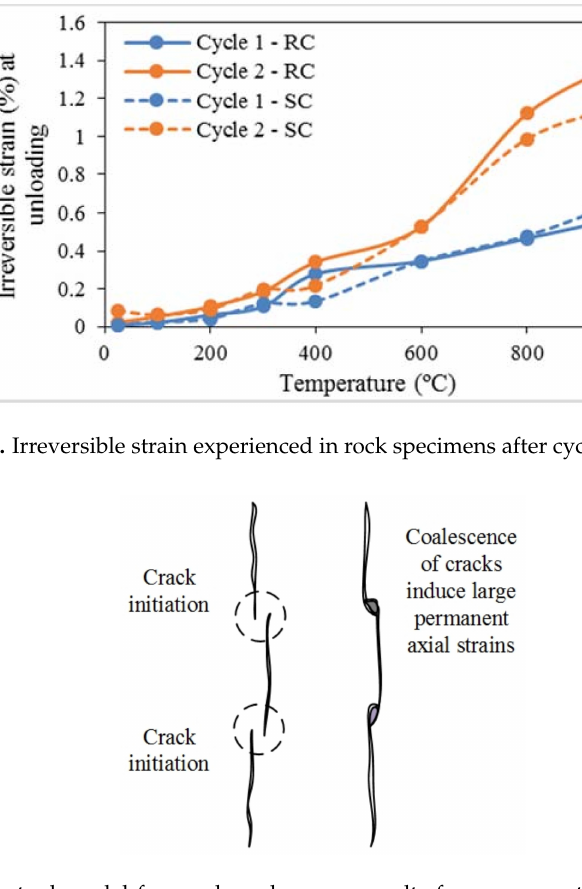
Figure 14. Conceptual model for crack coalescence results for permanent axial strains and crack damage. Modified after Eberhardt